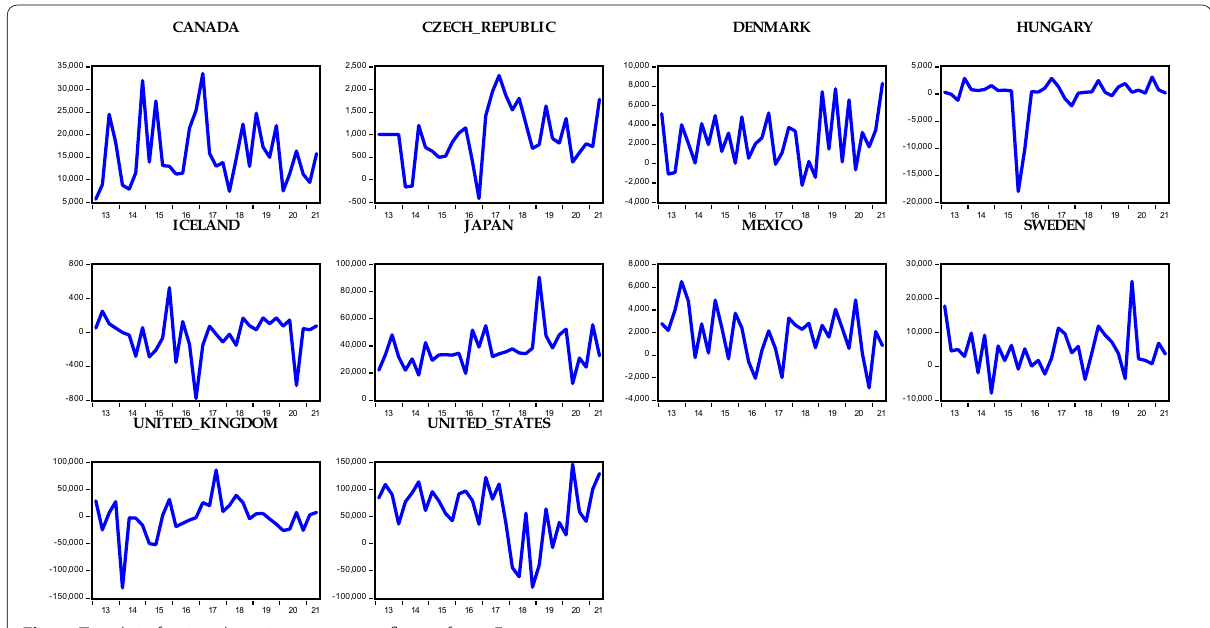
Fig. 4 Trends in foreign direct investment outflows of non-Eurozone countries